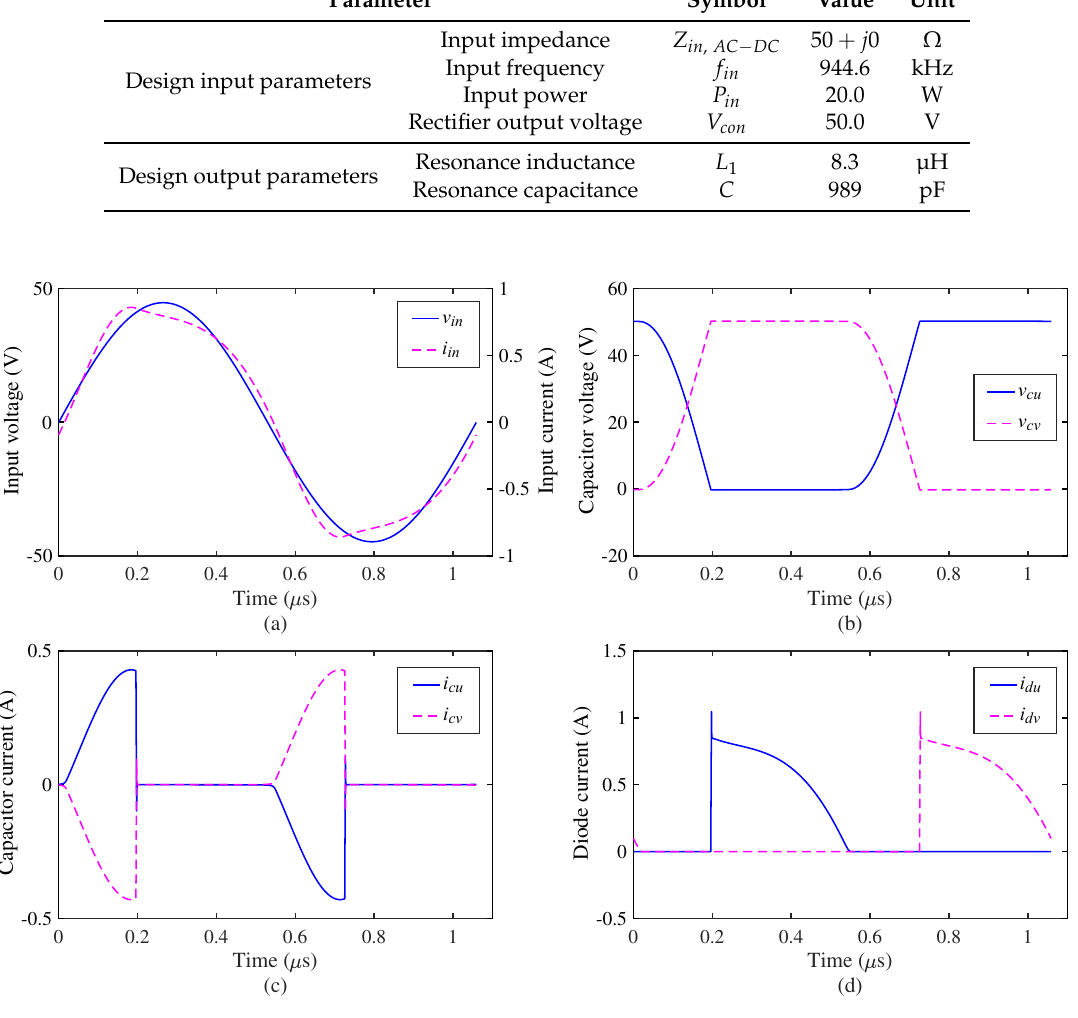
Figure 10. PSpice simulation waveforms of the AC-DC converter used in the system: ( a ) Waveforms of the input voltage and input current; ( b ) Waveforms of the voltages across C 1 and C 2 ; ( c ) Waveforms of the currents through C 1 and C 2 ; ( d ) Waveforms of the currents through D 1 and D 2